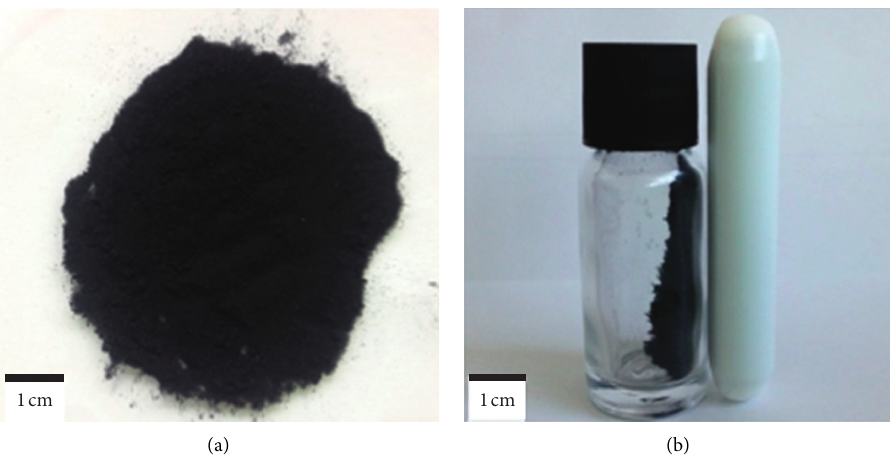
Figure 1: The FeNPs in (a) absence and (b) presence of an external magnetic